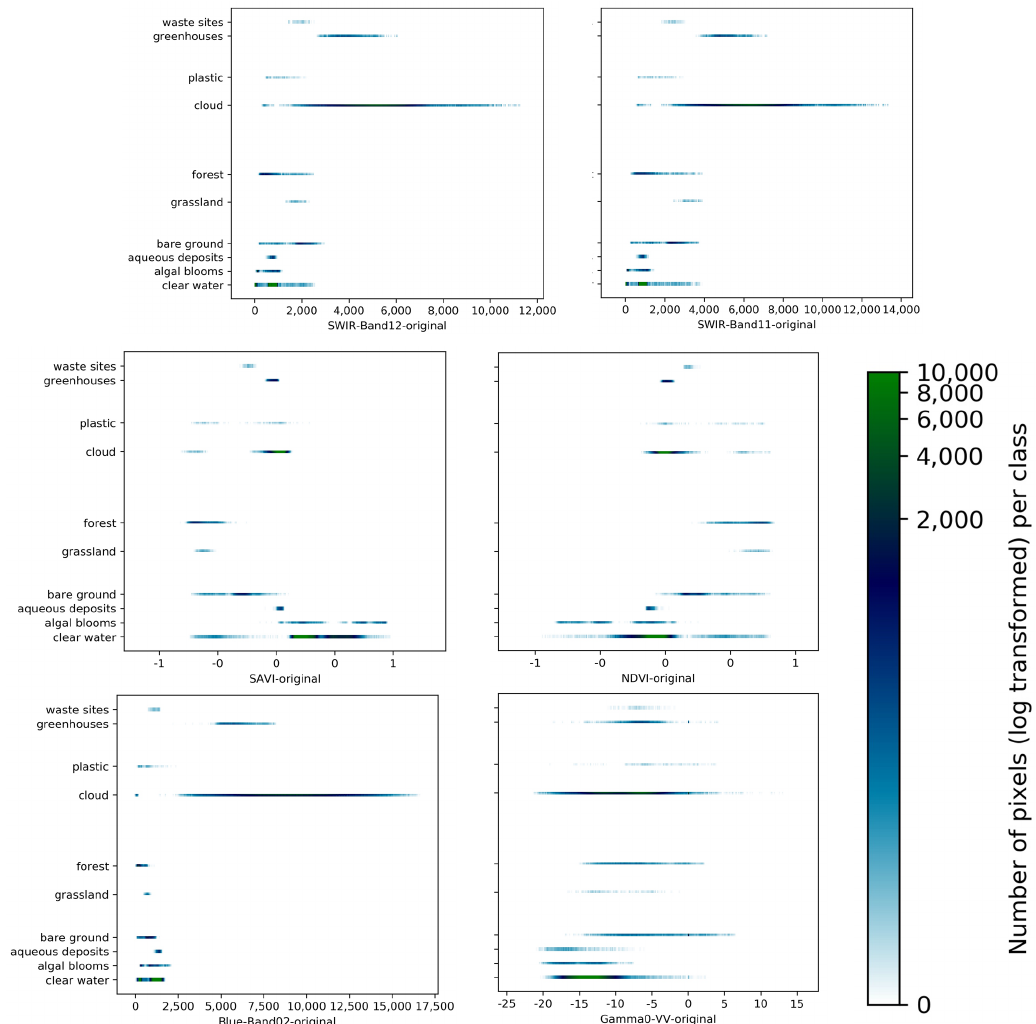
Figure 11. Horizontal density plots show the distribution of the values for the manually labelled pixels in each land cover class for the five test sites, for the Sentinel-2 bands 12 and 11 in the SWIR, SAVI and NDVI vegetation indices, Sentinel-2 band 2 (blue) and the Sentinel-1 Gamma0 VV layers.